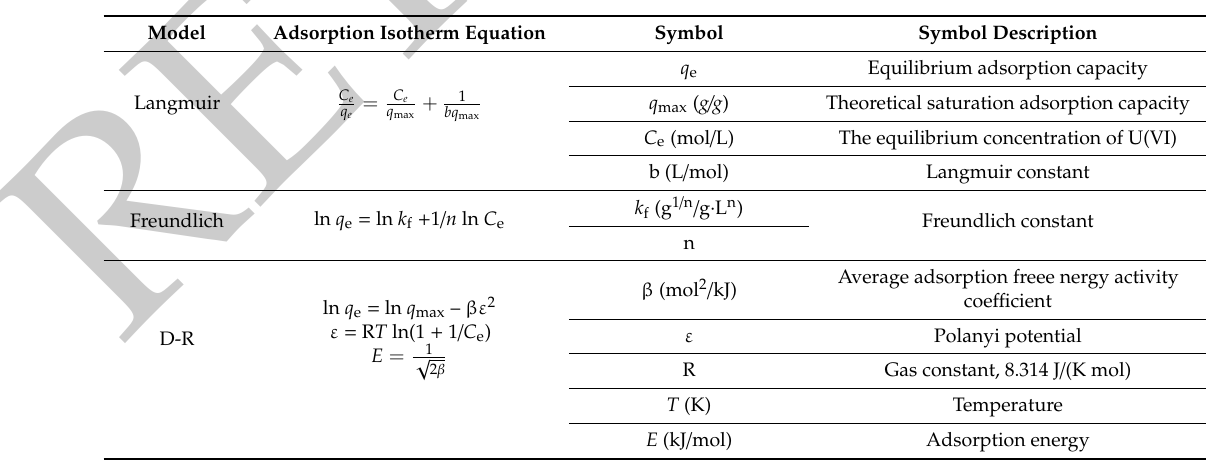
Table 3. Frequently used adsorption isotherm model.